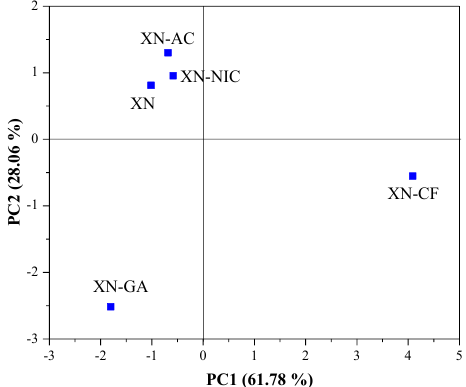
Figure 13. Principal component analysis (PCA) two-dimensional (2D) score plot (PC1 vs. PC2) calculated for the data acquired from the Raman spectra.